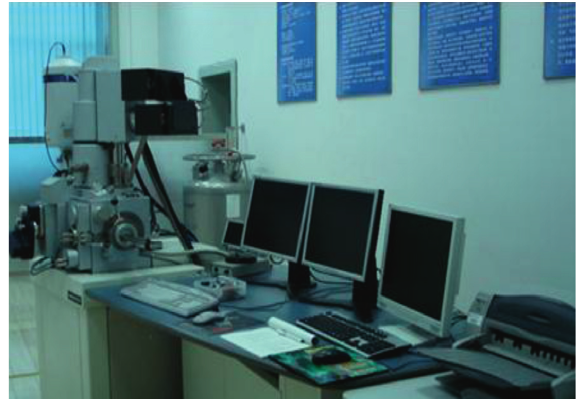
Figure 9: CamScan MX2600-type thermal field emission scanning electron